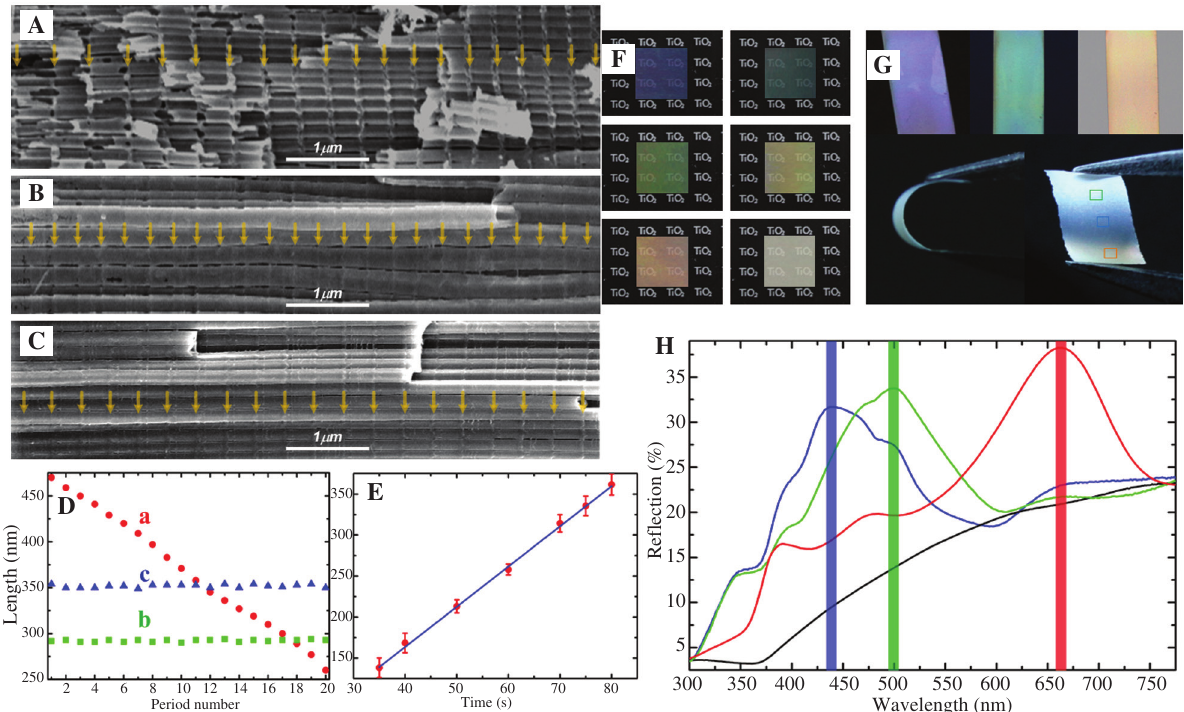
Figure 8 The SEM images of NT microstructures showing the variation of the period length along the tube direction. (A) NTs with irregular periods fabricated under voltage pulse anodization, and (B, C) regular periods by current pulse anodization, with two different average lengths of 292 and 352 nm. (D) The detailed variation of the period length with the period number of the samples shown in (A)–(C). (E) The variation of the period length with the duration of high current limit, showing a linear relationship. (F) The tunable colors of films over the entire visible region with different period lengths. The film at the bottom side of the white color is common NTs fabricated by constant current anodization with no period along the tube axis. (G) By changing the incident or viewing angles, the film color of a specific sample changes greatly through the entire visible spectrum: purple, green and red. And the lower part shows the colorful films with the excellent flexibility. (H) The reflection measurements showing the optical properties of representative colorful films. The black curve is the reflec- tion of the white sample shown in (F). Reprinted with permission from Ref. [228]. Copyright (2011) Wiley-VCH Verlag GmbH & Co. KGaA,